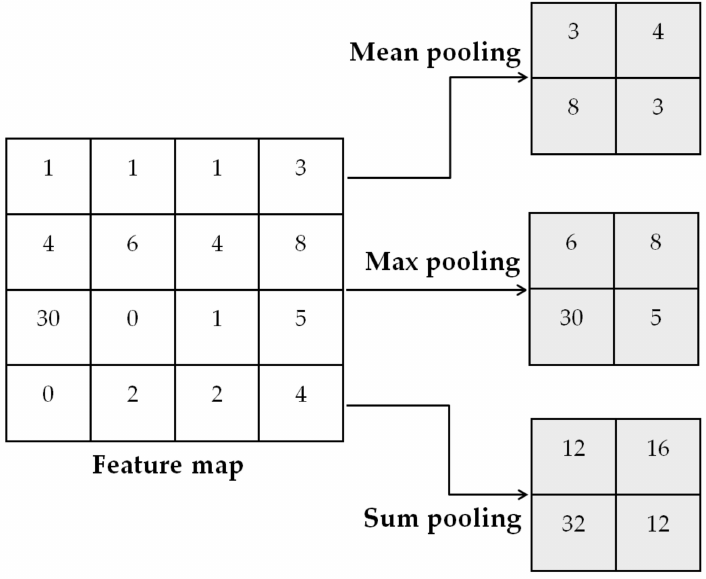
Figure 4. Examples of pooling using the mean, max and sum